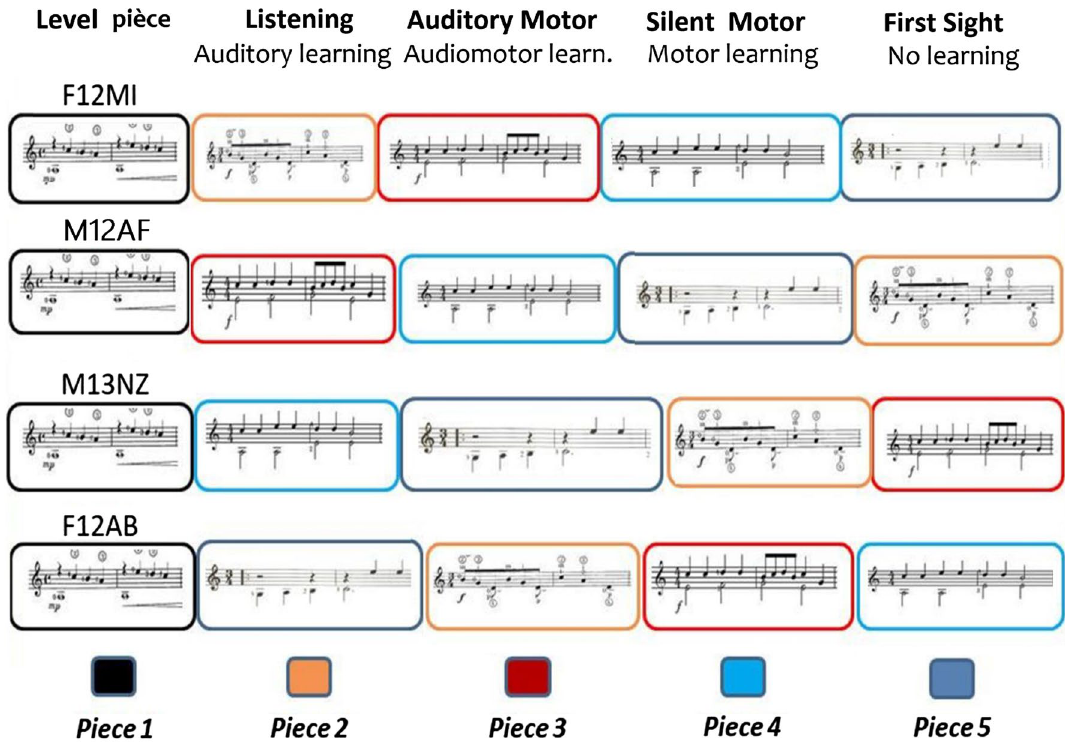
Figure 1. Example of piece randomization across the four experimental conditions for four students belonging to the same didactic level (beginners). The effectiveness of musical learning was evaluated in the same students under different practice conditions (on different pieces) and among students with different levels of proficiency. The same musical pieces (here indicated by the same colour, red, blue, etc.) were assigned to different study conditions across participants of the same